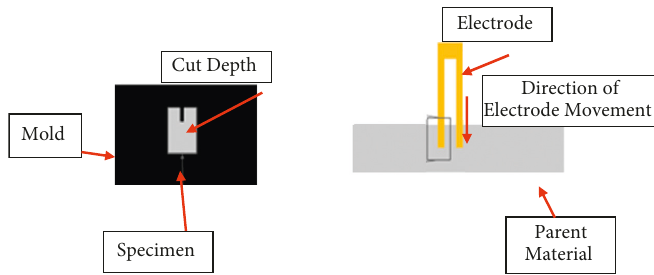
Figure 7: The schematic of the electrode wear specimen in SEM mold (left) and its origin from the workpiece cut (right).